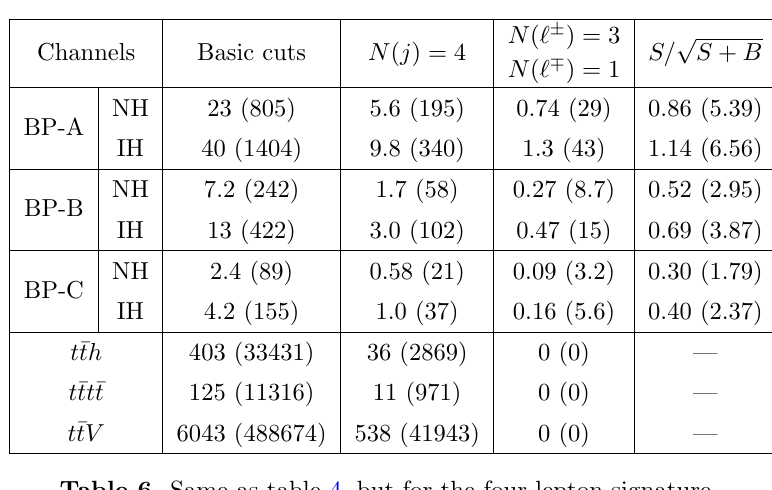
Table 6 . Same as table 4, but for the four-lepton signature.